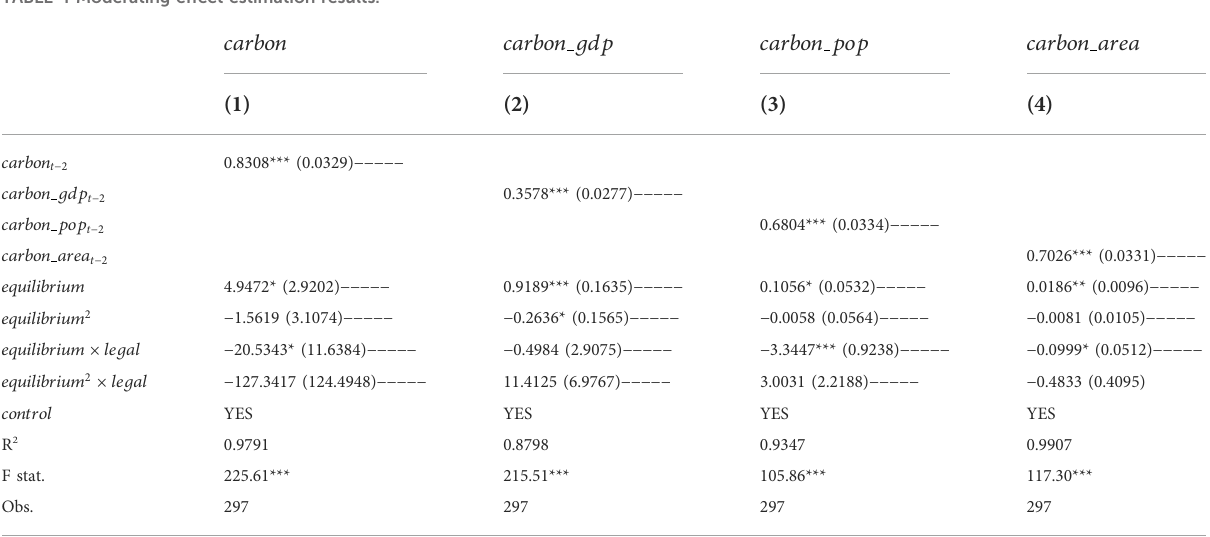
TABLE 4 Moderating effect estimation